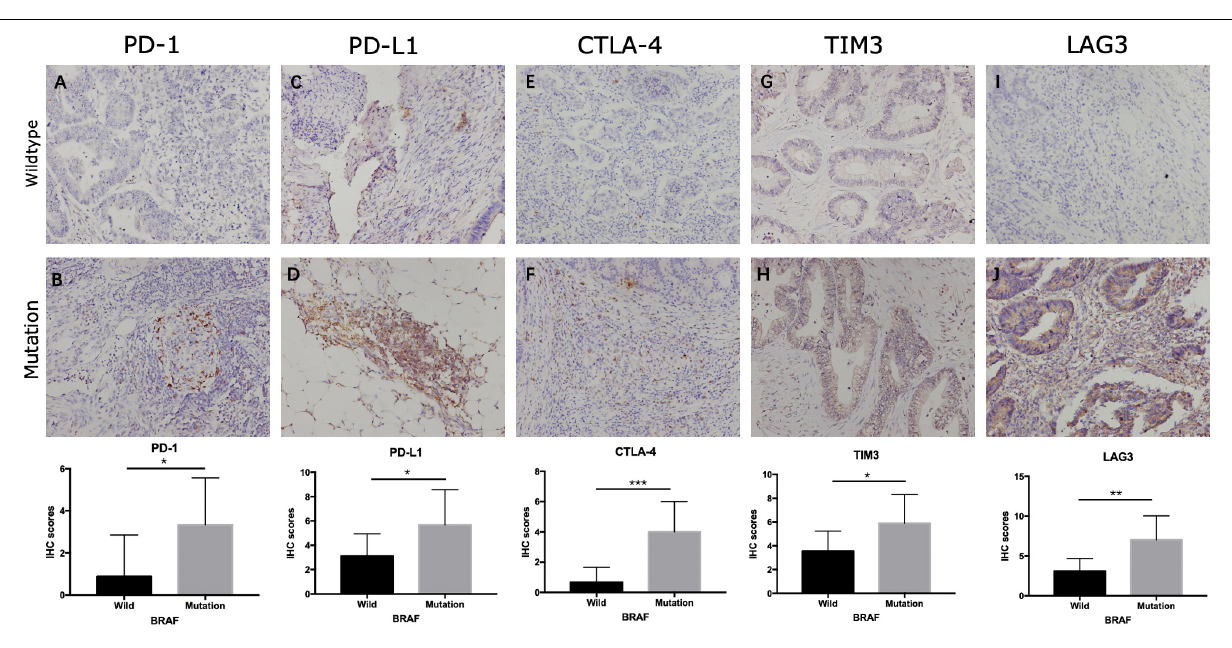
FIGURE 8 | Representative IHC staining showing expression of immunotherapy-related genes in colon cancer. Staining of PD-1 (A,B) , PD-L1 (C,D) , CTLA-4 (E,F) , TIM-3 (G,H) , and LAG-3 (I,J) in BRAF wild-type (A,C,E,G,I) and BRAF mutated (B,D,F,H,J) samples at magnification × 200. * p < 0.05, ** p < 0.01, *** p <